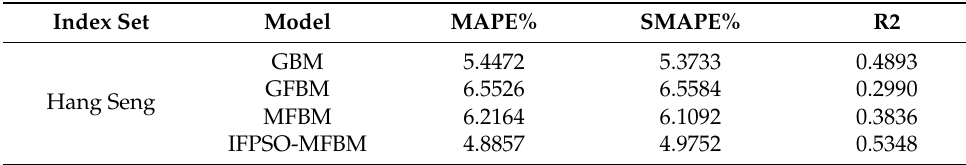
Table 8. Comparative error analysis of Hang Seng index under four models.